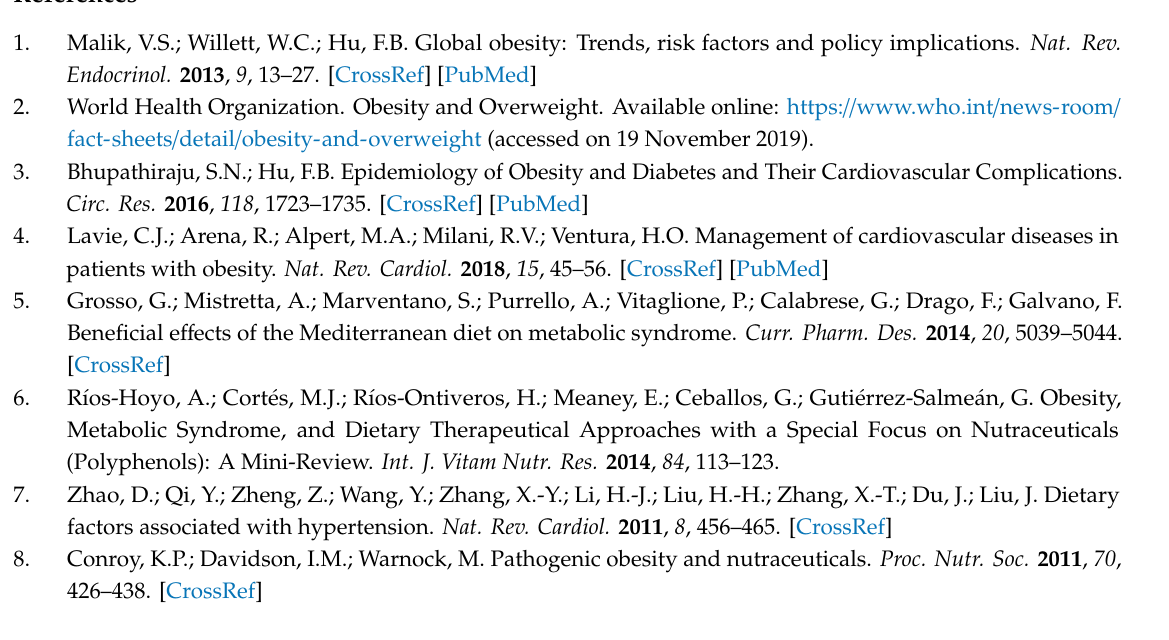
Figure S1: The e ff ect of a POCTA diet on liver triglycerides in mice fed a standard diet (SD), high-fat diet (HFD), or a diet supplemented in olive pomace oil with high concentration in triterpenic acids